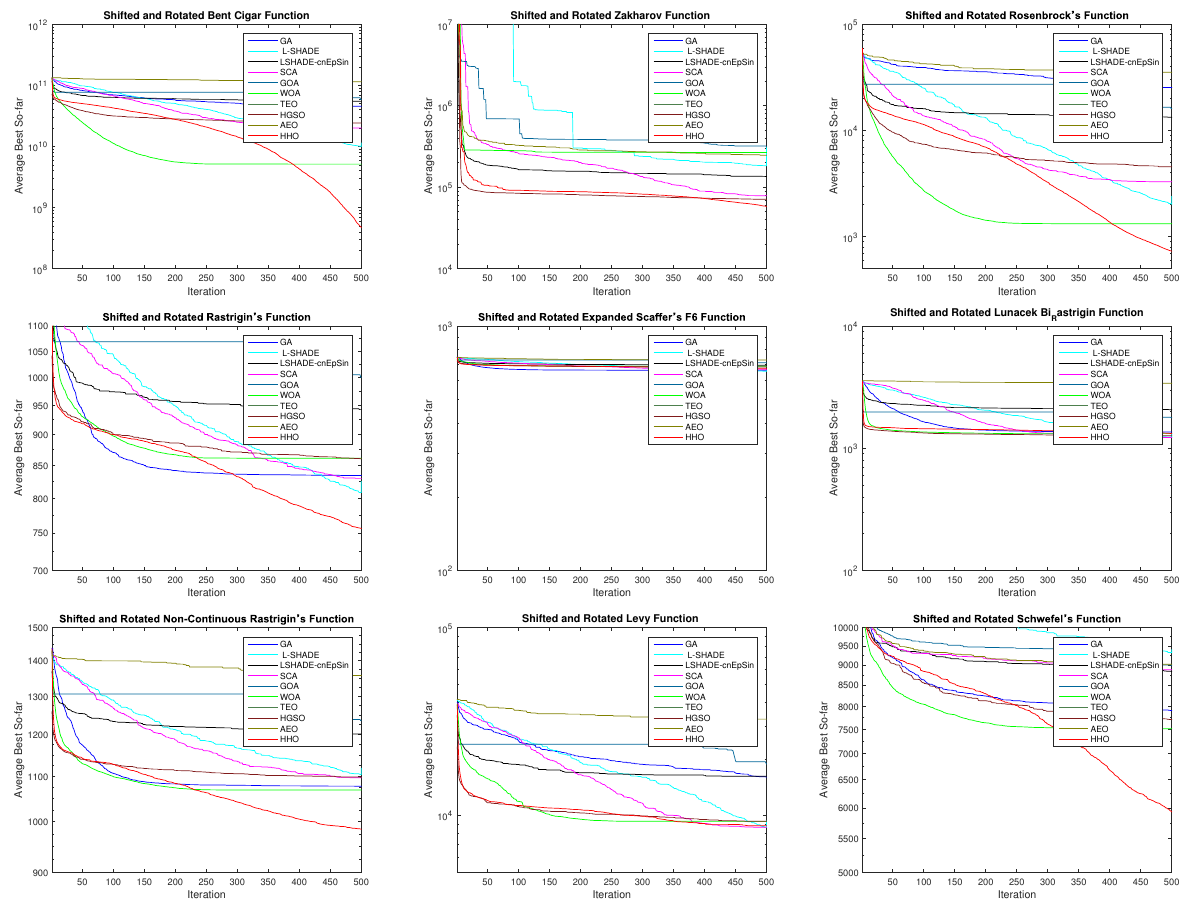
Figure 6. Convergence curve for HHO against other competitors from F1–F10 CEC2017.